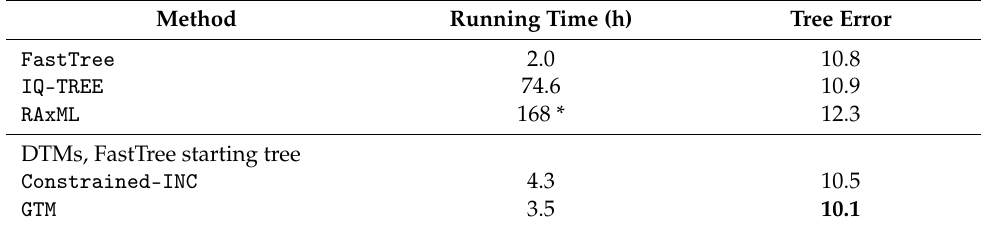
Table 6. Results on the RNASim10k datasets The average running time (in hours, assuming use of 16 cores) and tree error (FN) rates over 10 replicates. Each method was given 64 GB. The asterisk (*) for RAxML running time indicates that it had not completed by that time, and we used the best scoring tree that it found in that time period. The most accurate result is